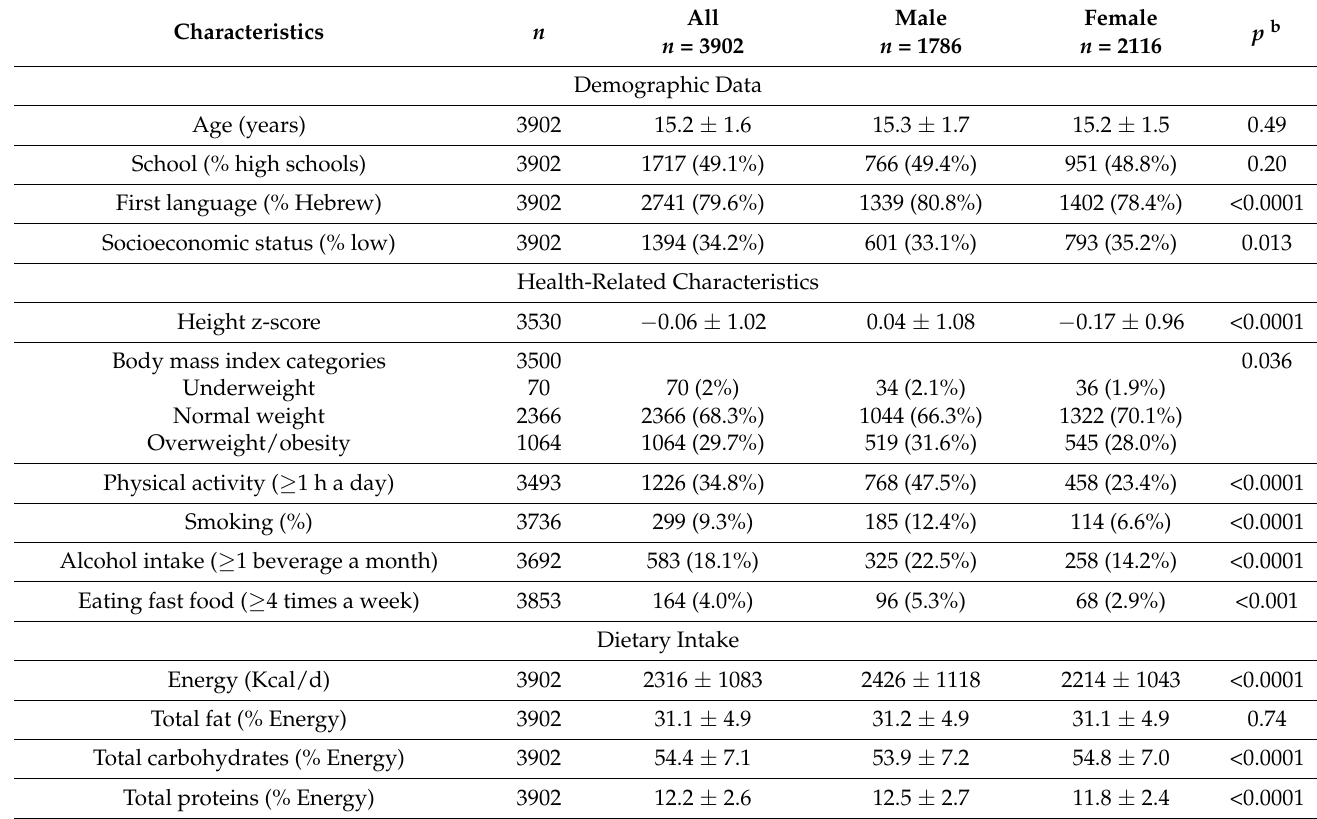
Table 1. Selected sociodemographic, dietary intake and health-related characteristics of the study participants by sex a .